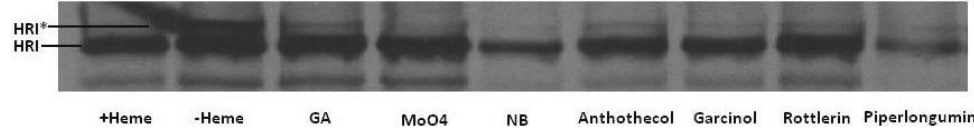
Figure 13. Effect of compounds on HRI’s Hsp90 -dependent maturation. [ 35 S]Labeled-HRI was synthesized by TnT in RRL and transferred to heme-deficient lysate for maturation.